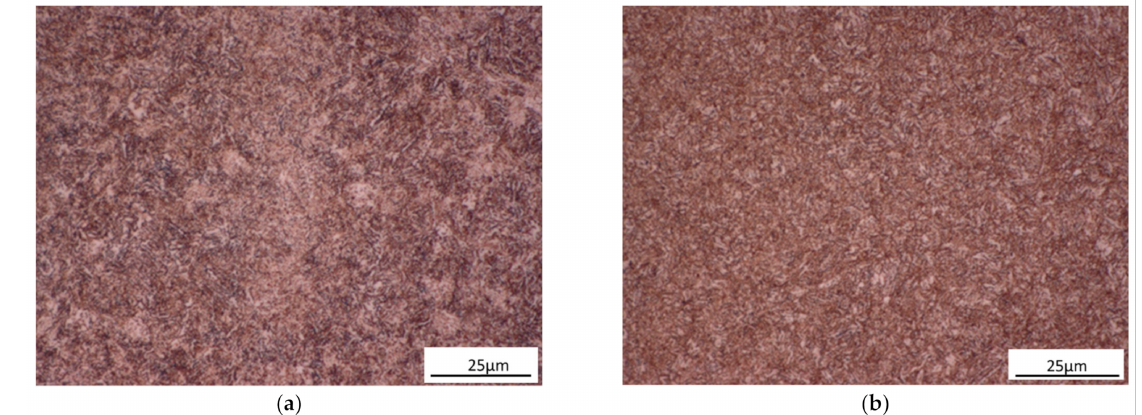
Figure 3. Optical microscopy of the microstructure of AISI6150 steel: ( a ) 343 ◦ C austempered disks, ( b ) 585 ◦ C quenched- tempered disks.